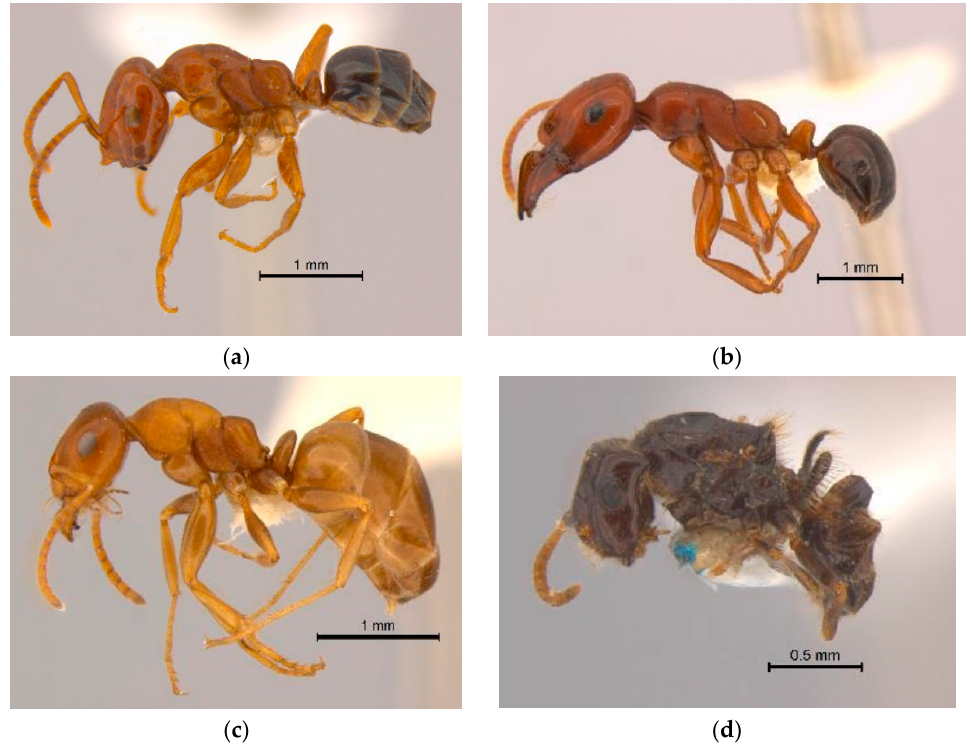
Figure 3. Representatives of the M. potteri group. ( a ) Member of complex 1; ( b ) member of complex 2; ( c ) member of complex 3; and ( d ) member of complex 4.